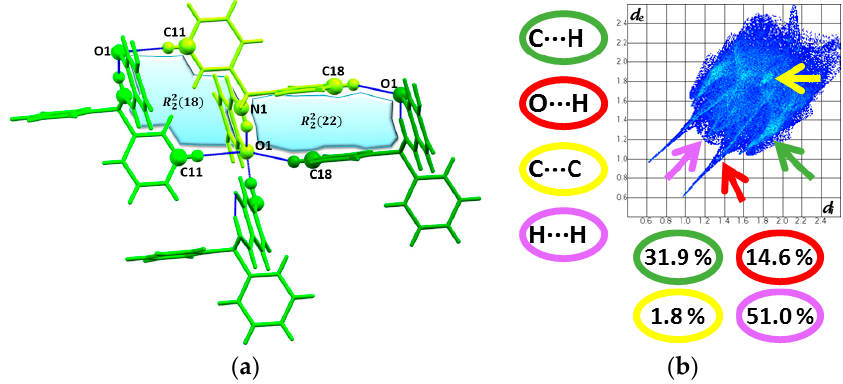
Figure 4. View of ( a ) a tetramer of mOHsaladpm molecules formed by means of O–H···O and C–H···O interactions and ( b ) the 2D-fingerprint plot with marked corresponding regions: green arrow for C···H contacts, red arrows for O···H contacts, yellow arrow for C···C contacts and violet arrow for H···H contacts. pOHsaladpm crystallizes in the P 2 1 / c space group of monoclinic system with four molecules per unit cell. The molecules are found to be in enol-imine tautomeric form. Two chains of the molecules